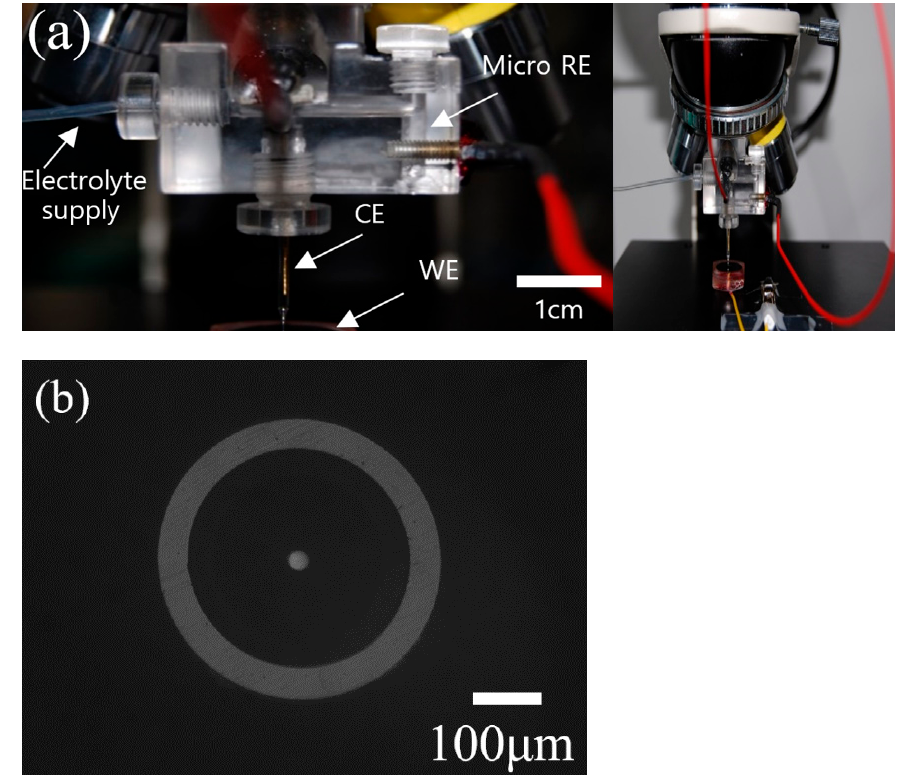
Figure 1. Experimental setup of ( a ) the specially designed microdroplet cell and ( b ) the diameter of the capillary tip (RE: reference electrode; WE: working electrode; CE: counter electrode).